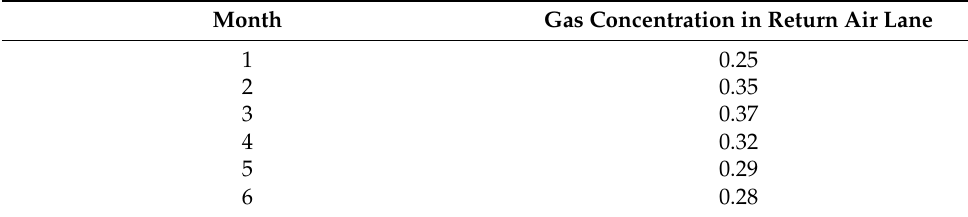
Table 6. Gas concentration